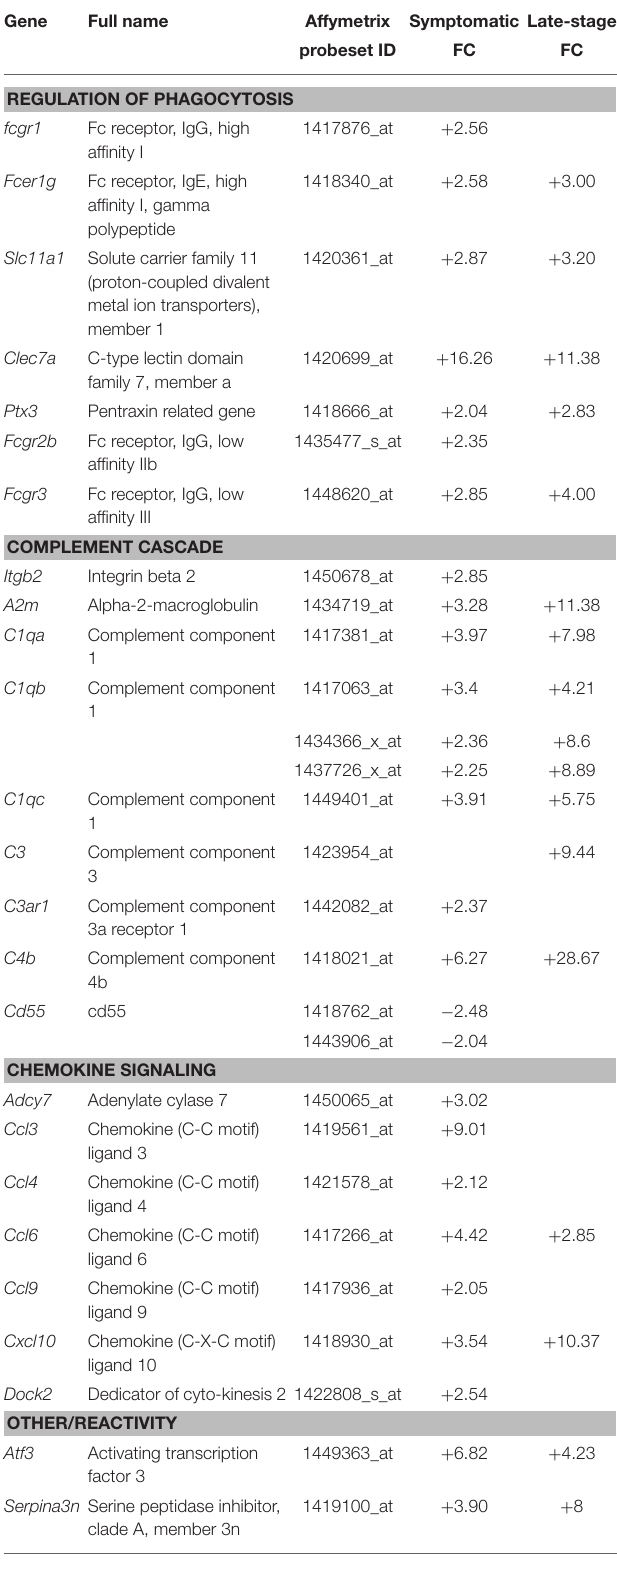
TABLE 3 | Genes involved in the phagocytic and immune response categories that are differentially expressed in symptomatic and